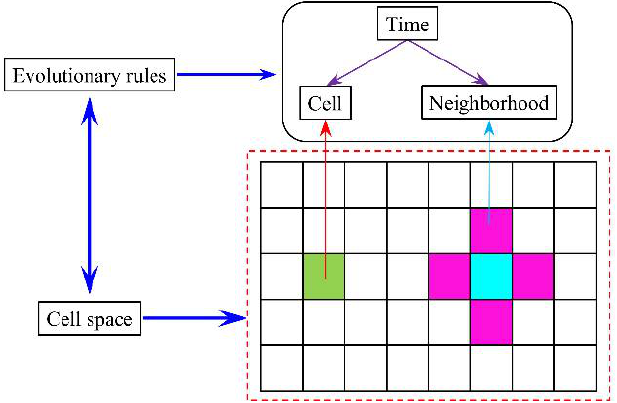
Figure 1. Relationship between components of cellular automata.